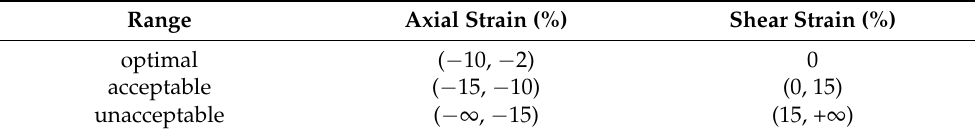
Table 5. Classification of axial and shear strain in the optimal, acceptable and unacceptable ranges.